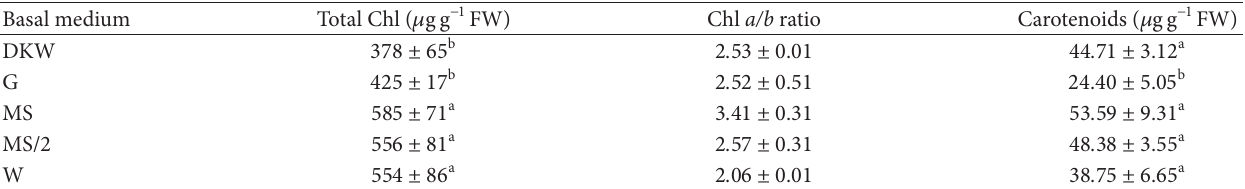
Table 3: Effect of basal media formulations on total chlorophyll (chl a + b ) content, chl a / b ratio, and carotenoids levels of C. heterophyllus after 4 weeks of culture in liquid media.